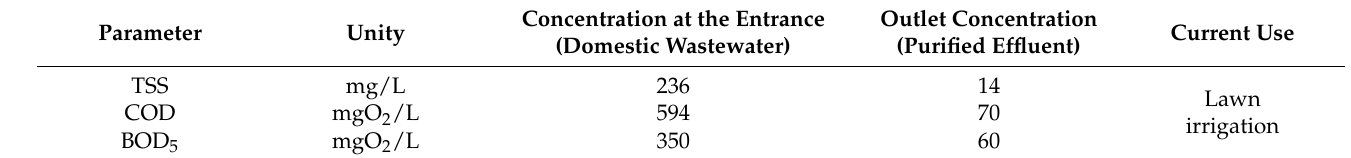
Table 3. Characterization of wastewater samples from